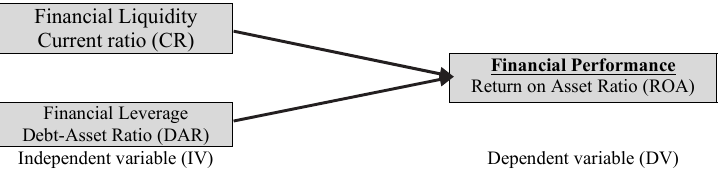
Fig. 1. Conceptual framework model relating financial liquidity and financial leverage to the financial performance of Property and Real Estate Enterprises.